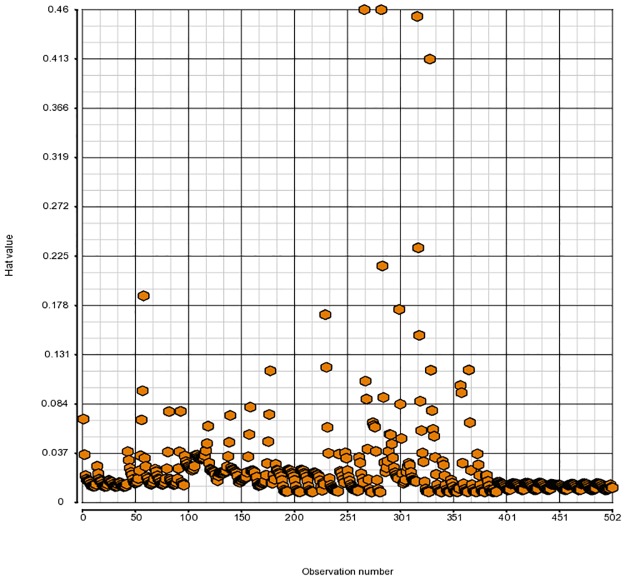
Hat values for model (11, 6) from Table 1.